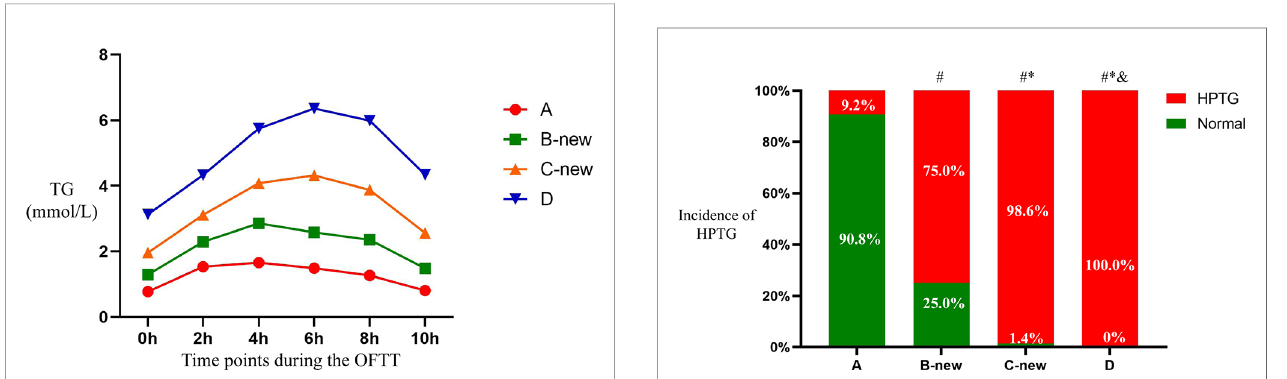
FIGURE 4 | Incidence of HPTG in groups with different FTG concentrations. Incidence of postprandial hypertriglyceridemia were analyzed to evaluate differences among groups with different fasting triglycerides concentrations. All data are expressed as percentage. # P < 0.05 vs. group A. *P < 0.05 vs. group B-new. & P < 0.05 vs. group